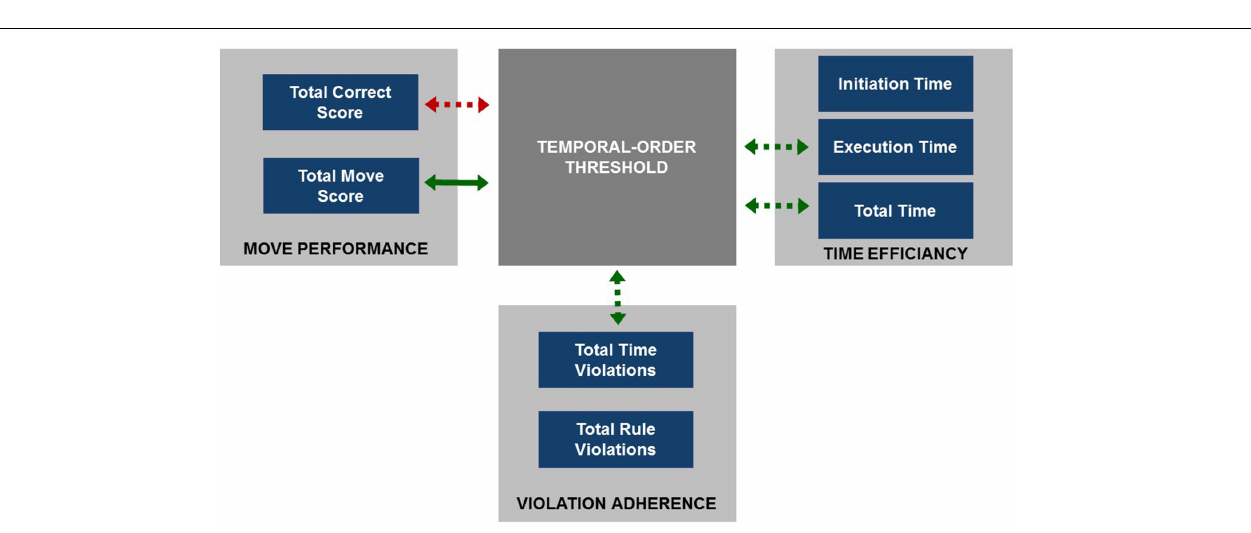
FIGURE 5 | Scatter data illustrating significant correlations between TOT values and outcome measures from TOL DX test: (A) ‘ Total Correct Score,’ (B) ‘ Total Move Score,’ (C) ‘Execution Time,’ (D) ‘Total Time,’ (E) ‘ Total Time Violations.’